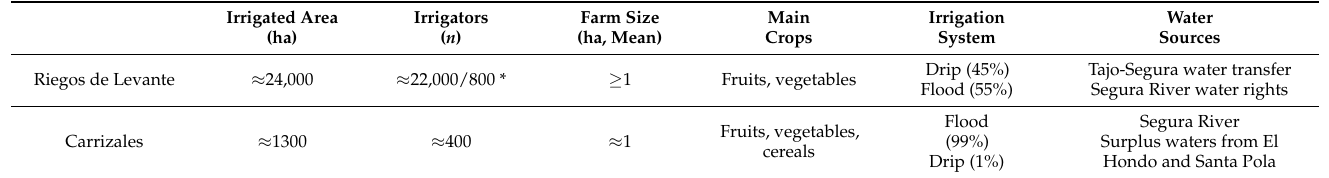
Table 1. Main characteristics of both irrigation